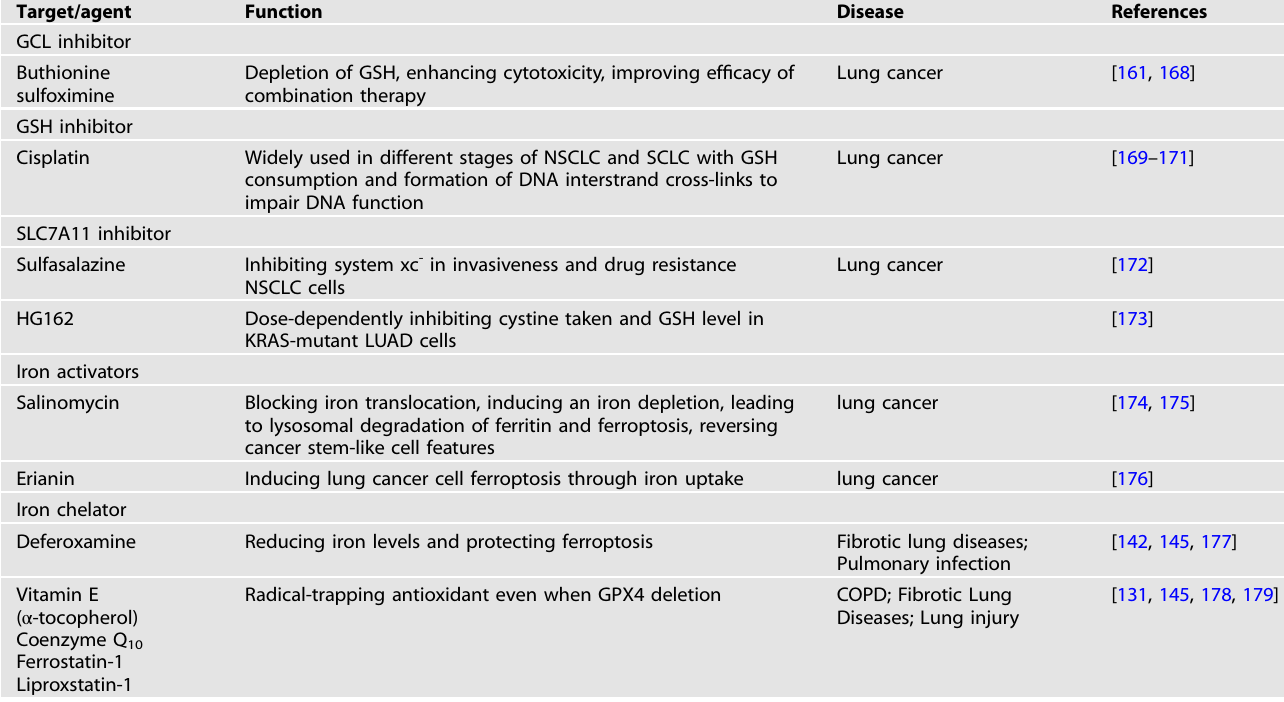
Table 3. Selected therapeutic approaches for targeting the ferroptosis pathway in pulmonary